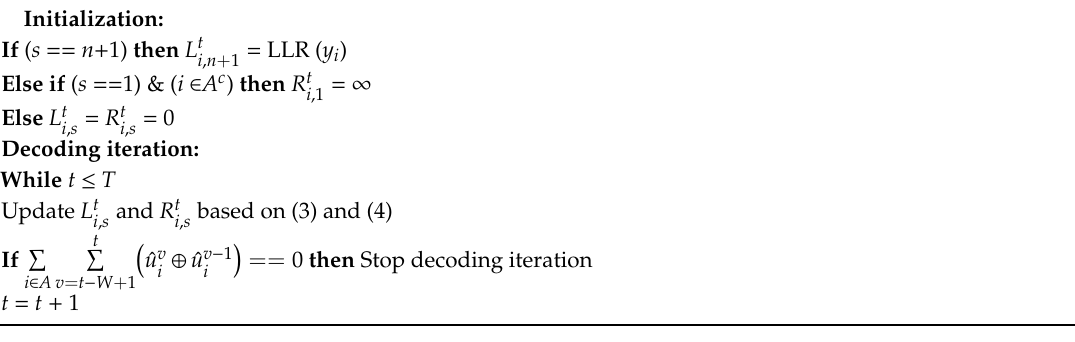
Algorithm 2: Information-BER-based [16] early-termination technique